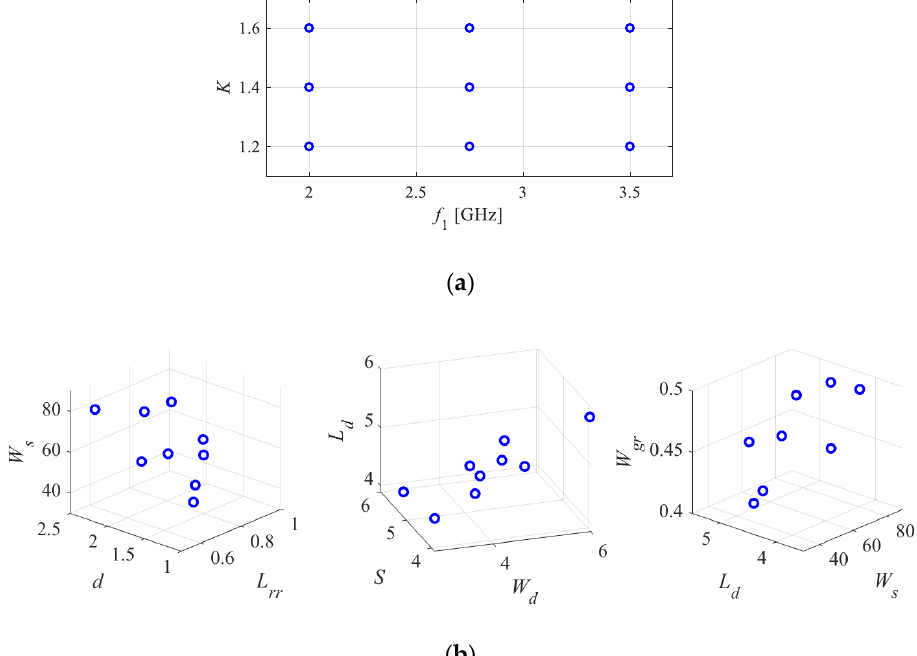
Table 1. Modeling Results for Antenna of Figure 6.